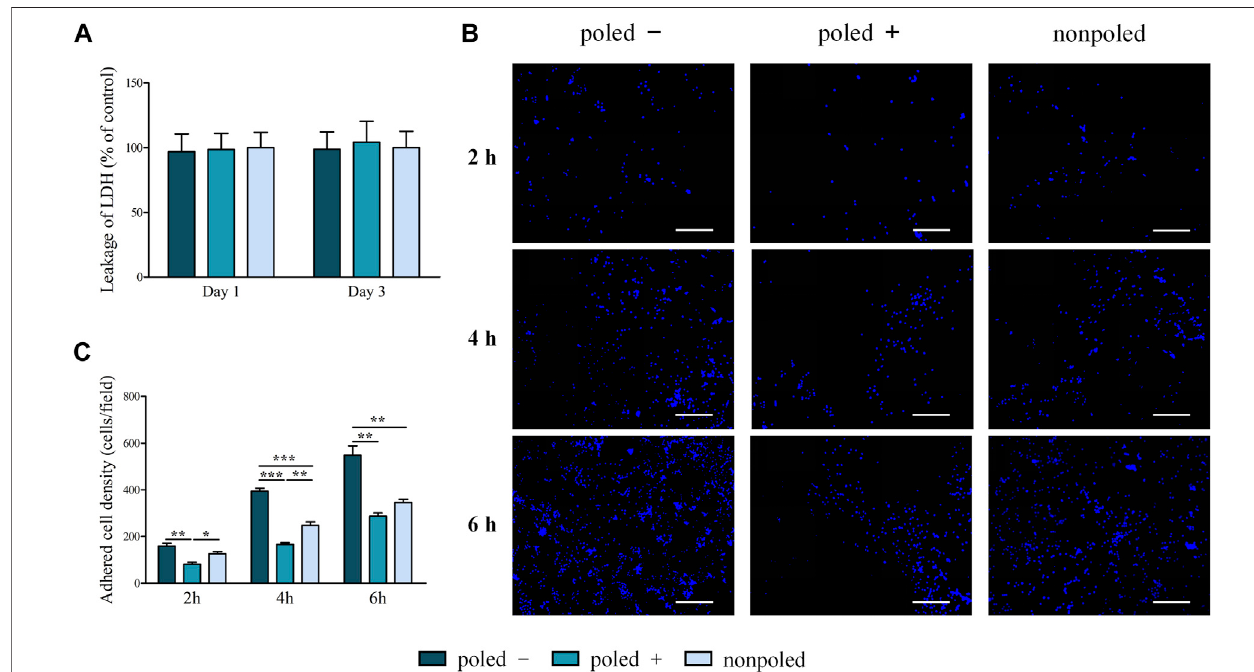
FIGURE 4 | Detection of cell adhesion and viability of macrophages cultured on P (VDF-TrFE) membranes. (A) Measurement of the LDH activity to evaluatethe cell viability of the charged P (VDF-TrFE) membranes (neutrally charged surfaces as control). (B) Representative fl uorescence images displaying the initial adhesion of macrophagesontheP(VDF-TrFE)membranesafter2,4,and6 hofincubation(scalebar:100 μ m). (C) Quanti fi cationofadhesivecells.* p < 0.05;** p < 0.01;*** p <